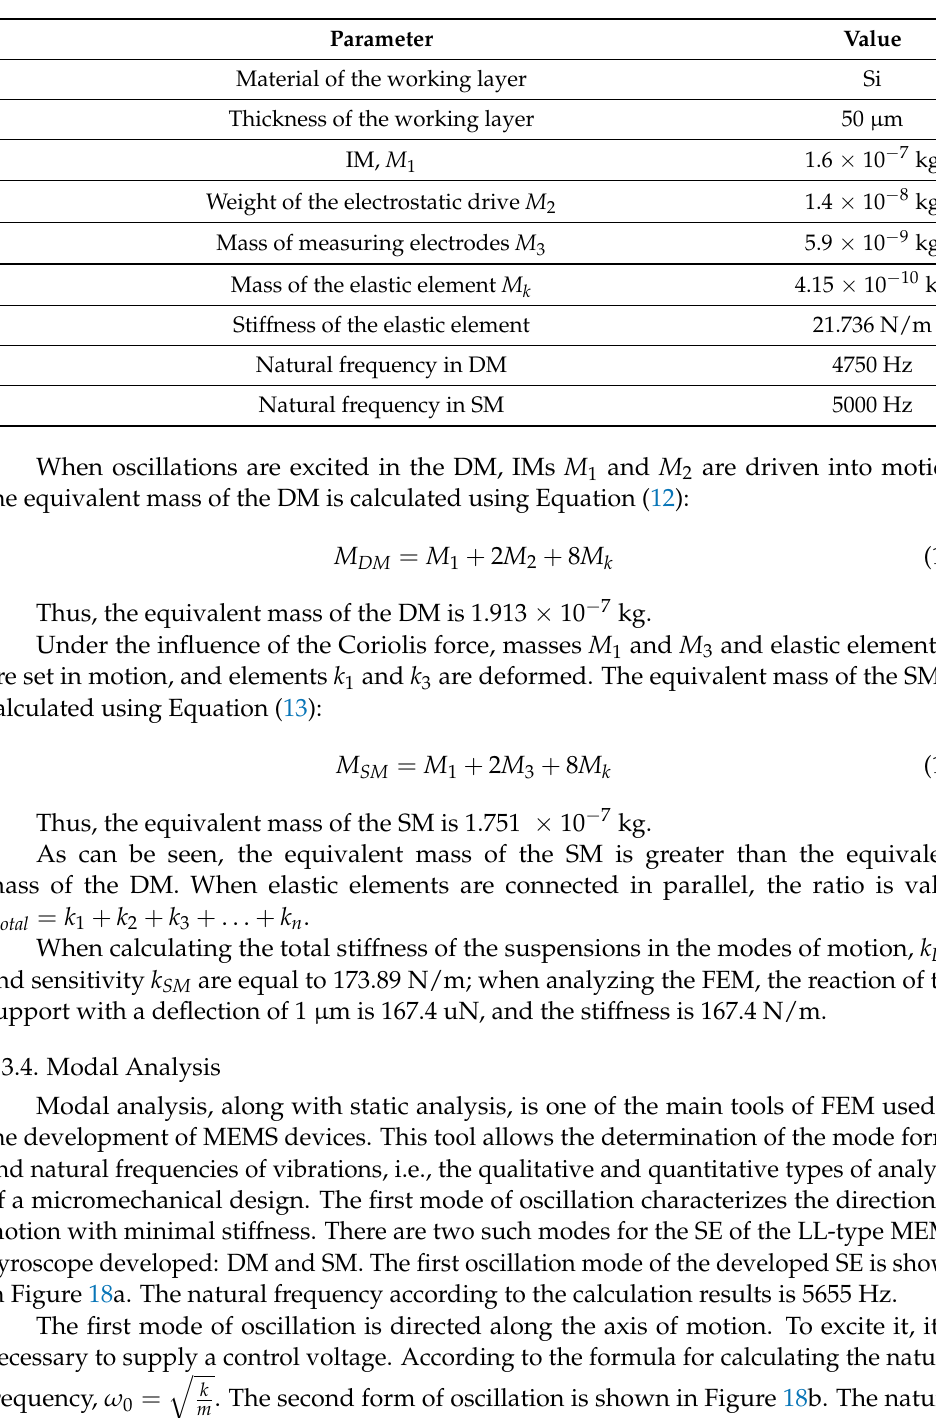
Table 6. Parameters of the elastic suspension of the